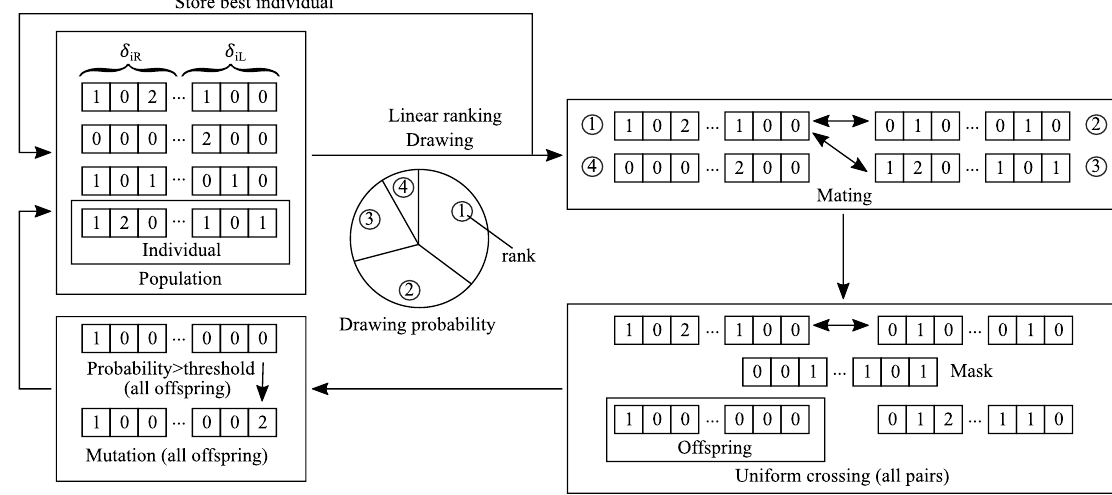
Figure 6. Multi-step signals optimization